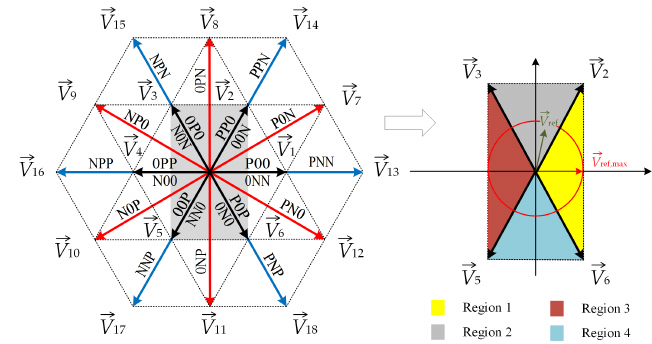
Figure 2. Vector diagram for the three-level